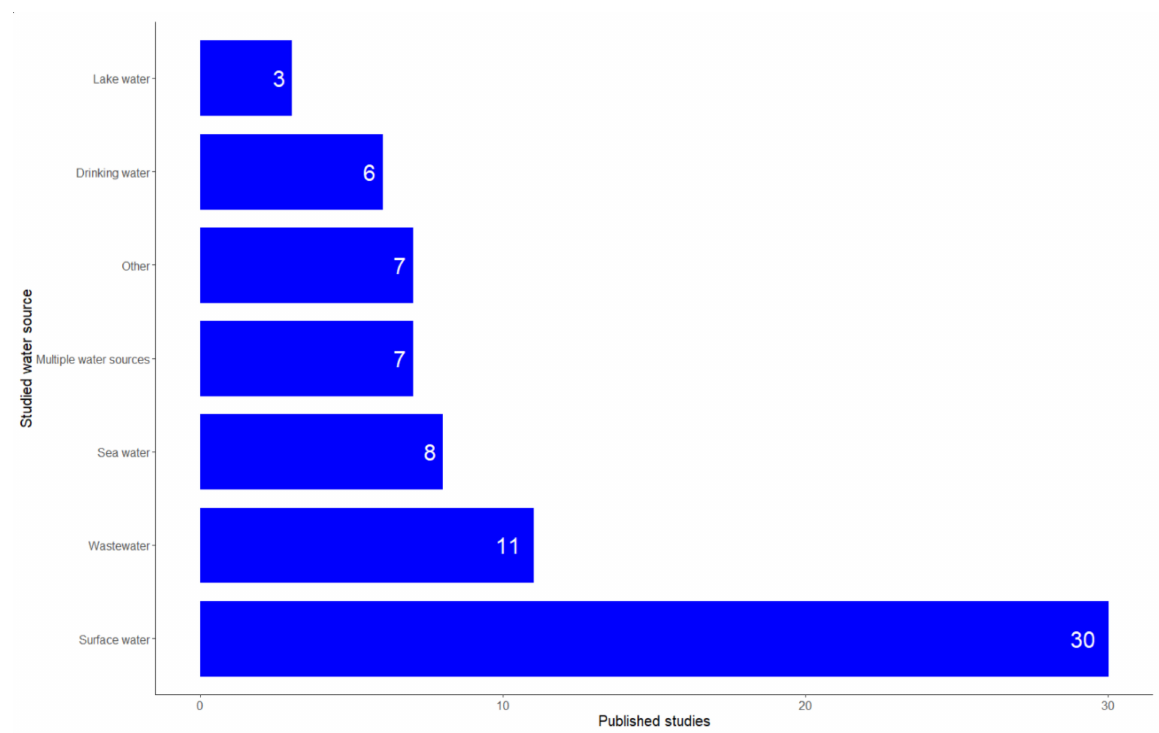
Figure 2. Most common water sources studied in Latin American countries. Multiple water sources included: river and drinking water, recreational, and irrigation water. Other water sources included estuarine, thermal, groundwater and different recreational waters.